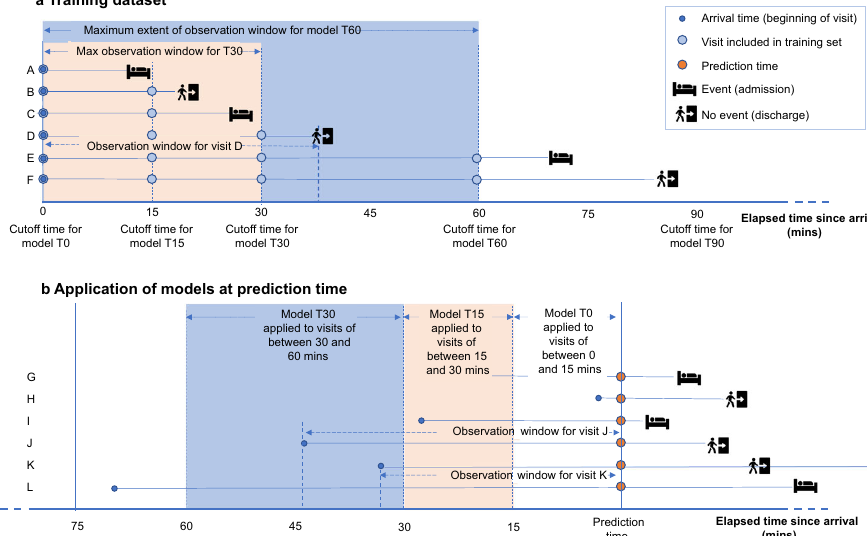
Fig. 8 Illustration of the temporal framing of model training and prediction, using fi ctional examples. A series of left-aligned datasets was constructed for training as shown in a with fi ctional examples. In each, the observation window began at the patient ’ s arrival time in the ED. Successive models were trained on longer observation windows. Model T0 had a zero minute cutoff, ie was given only the data known at the arrival time. Model T15 was trained on any data known up to 15 mins. Thus visit A, which lasted less than 15 min, only appears in T0. Model T30 was trained on any data known up to 30 min, so would only include data from visits D, E and F. To make predictions, right-aligned datasets of all patients in the ED at the time of prediction, as shown in b , were created. For each patient, the elapsed time of their visit determined which model was used to predict their probability of admission. Visit I began just less than 30 minutes before the prediction time, so this would be predicted by model T15. Visit K began just more than 30 minutes before the prediction time, so model T30 would be used for this